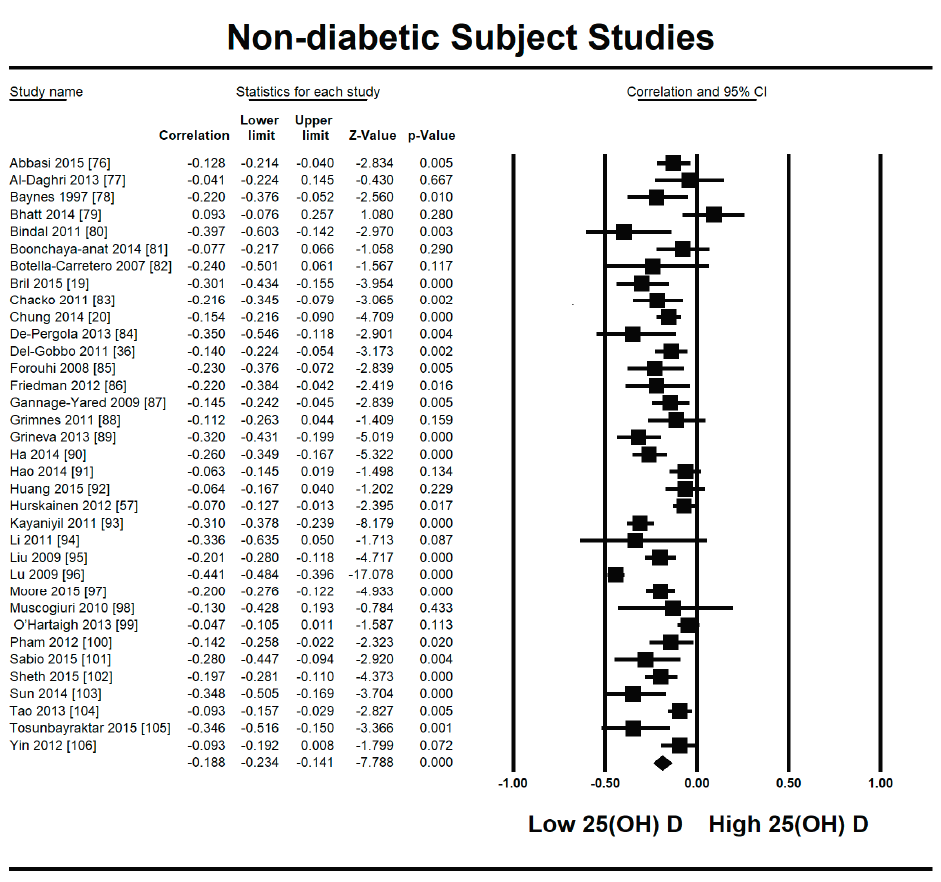
Figure 2. Forest plot for non-diabetic subject studies showing the correlation between status of vitamin D and fasting plasma insulin. The random effect model was used for the determination of correlation and 95% CI [19,20,57,76–106].